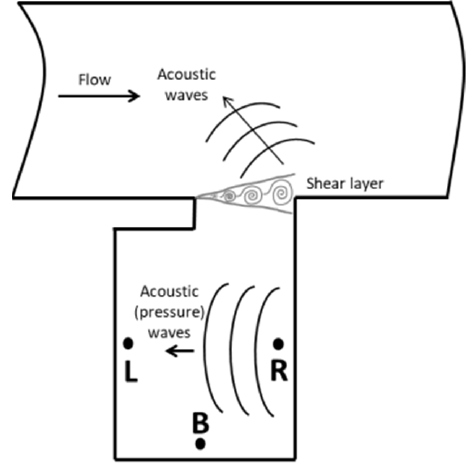
Figure 1. Cavity under